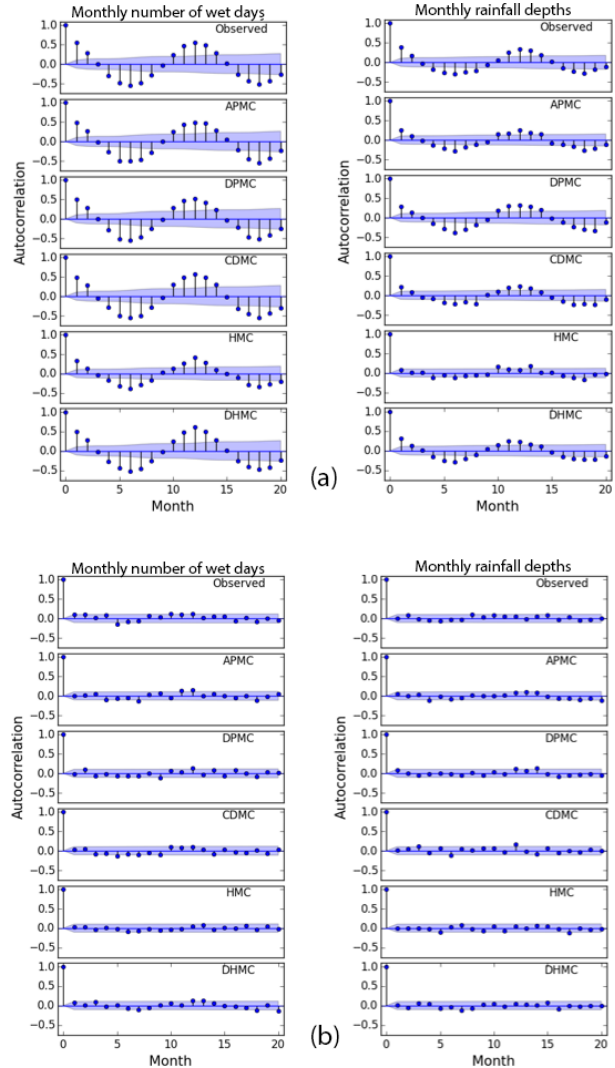
Figure 13. Comparison of the autocorrelations of monthly number of wet days and monthly rainfall depths for the five MC models for (a) Adelaide and (b) Sydney. The shadings indicate 95% confi- dence